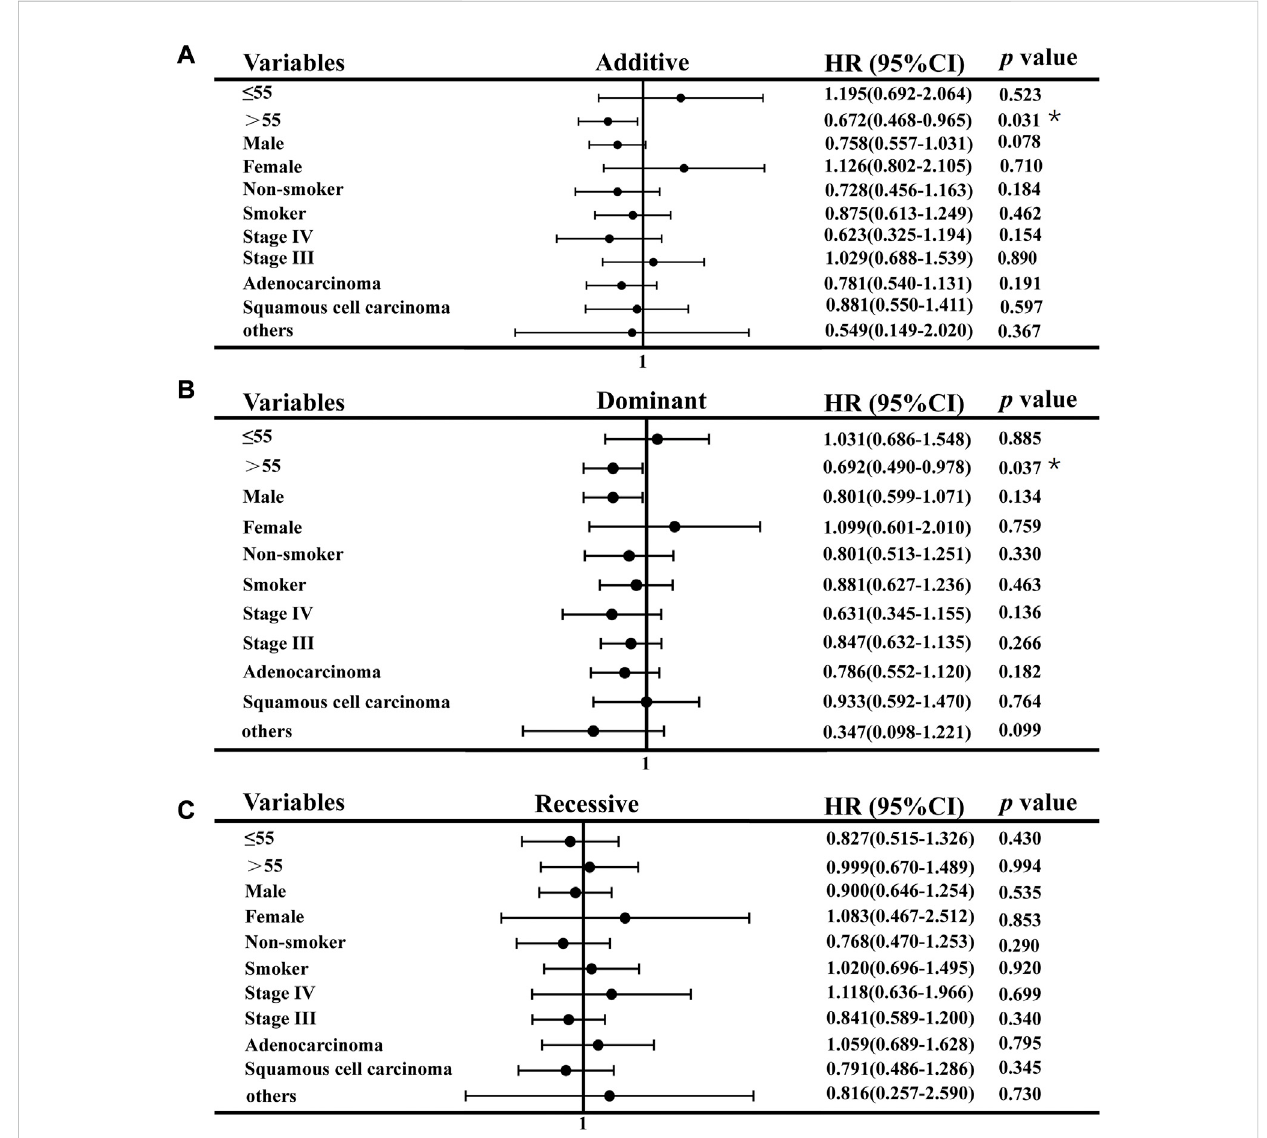
FIGURE 3 Association of CAT rs769217 and OS in Strati fi cation analyses, (A) additive model, (B) Dominant model, (C) Recessive model. p * < 0.05, p ** < 0.01.